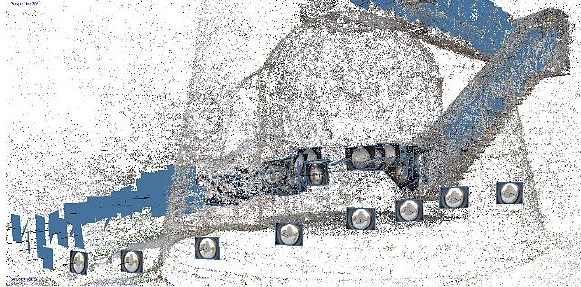
Figure 10. The RMSE (Root Mean Square Error) achieved following the two different strategies is reported in the Table 7.